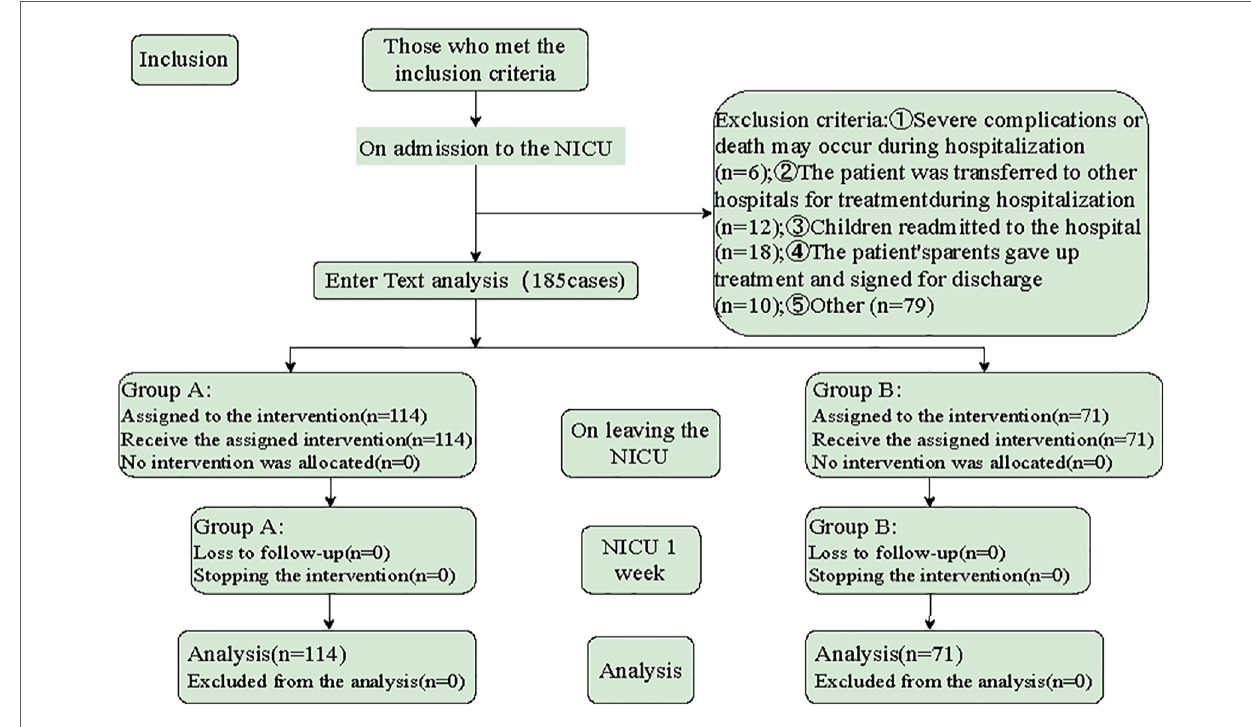
FIGURE 1 The selection process of research